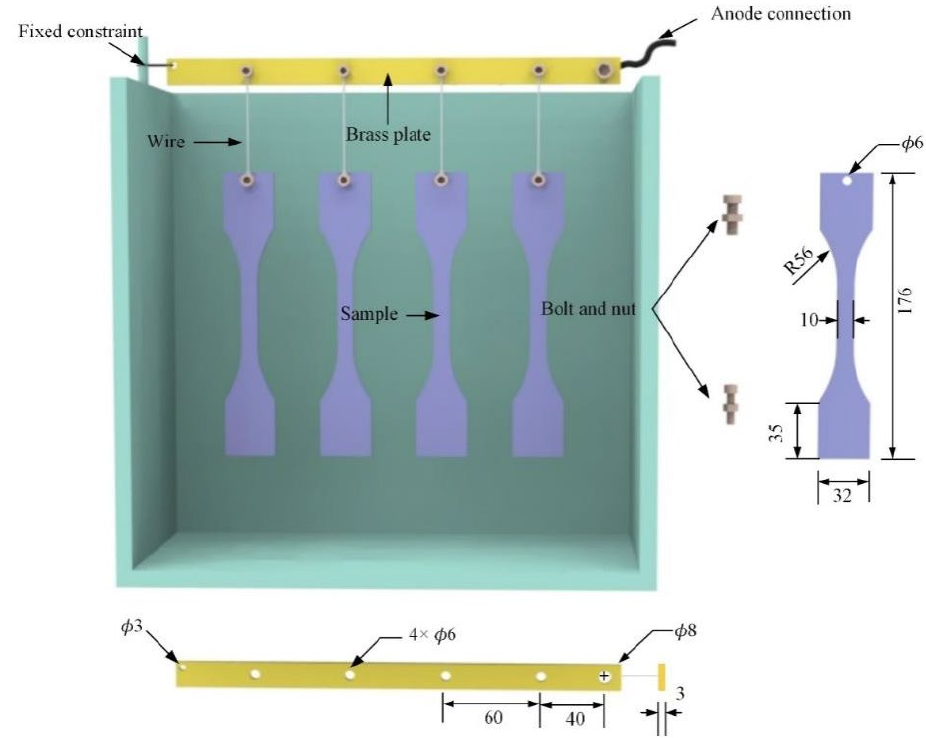
Figure 1. The schematic diagram of samples and fixture assembly.